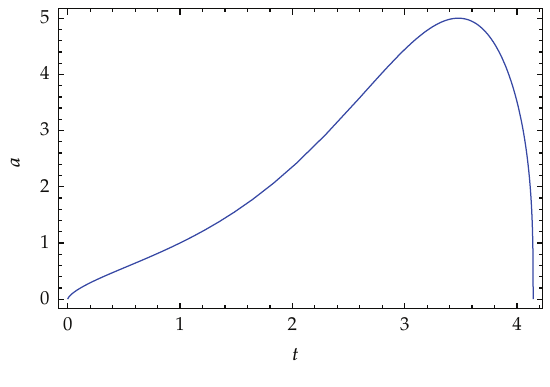
Figure 3: Scale factor a/a 0 versus t/t 0 .